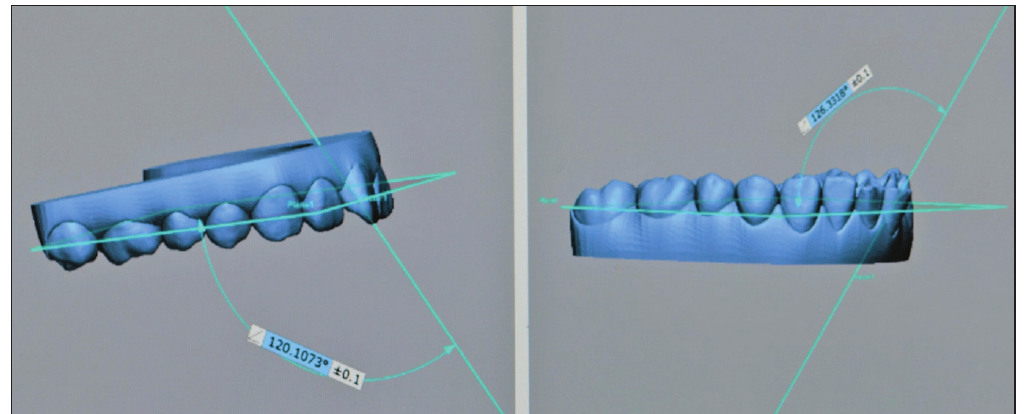
Figure 3. Measurement of